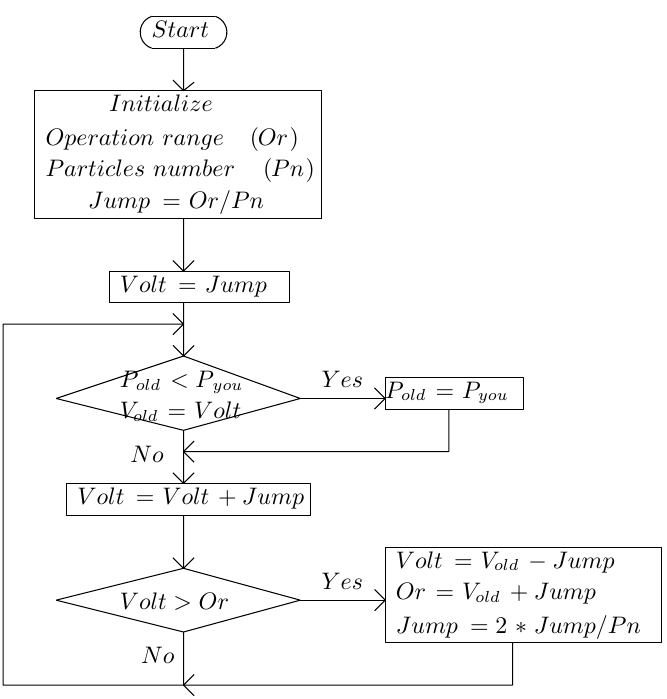
Figure 9. IPSM flow chart taken from [38].